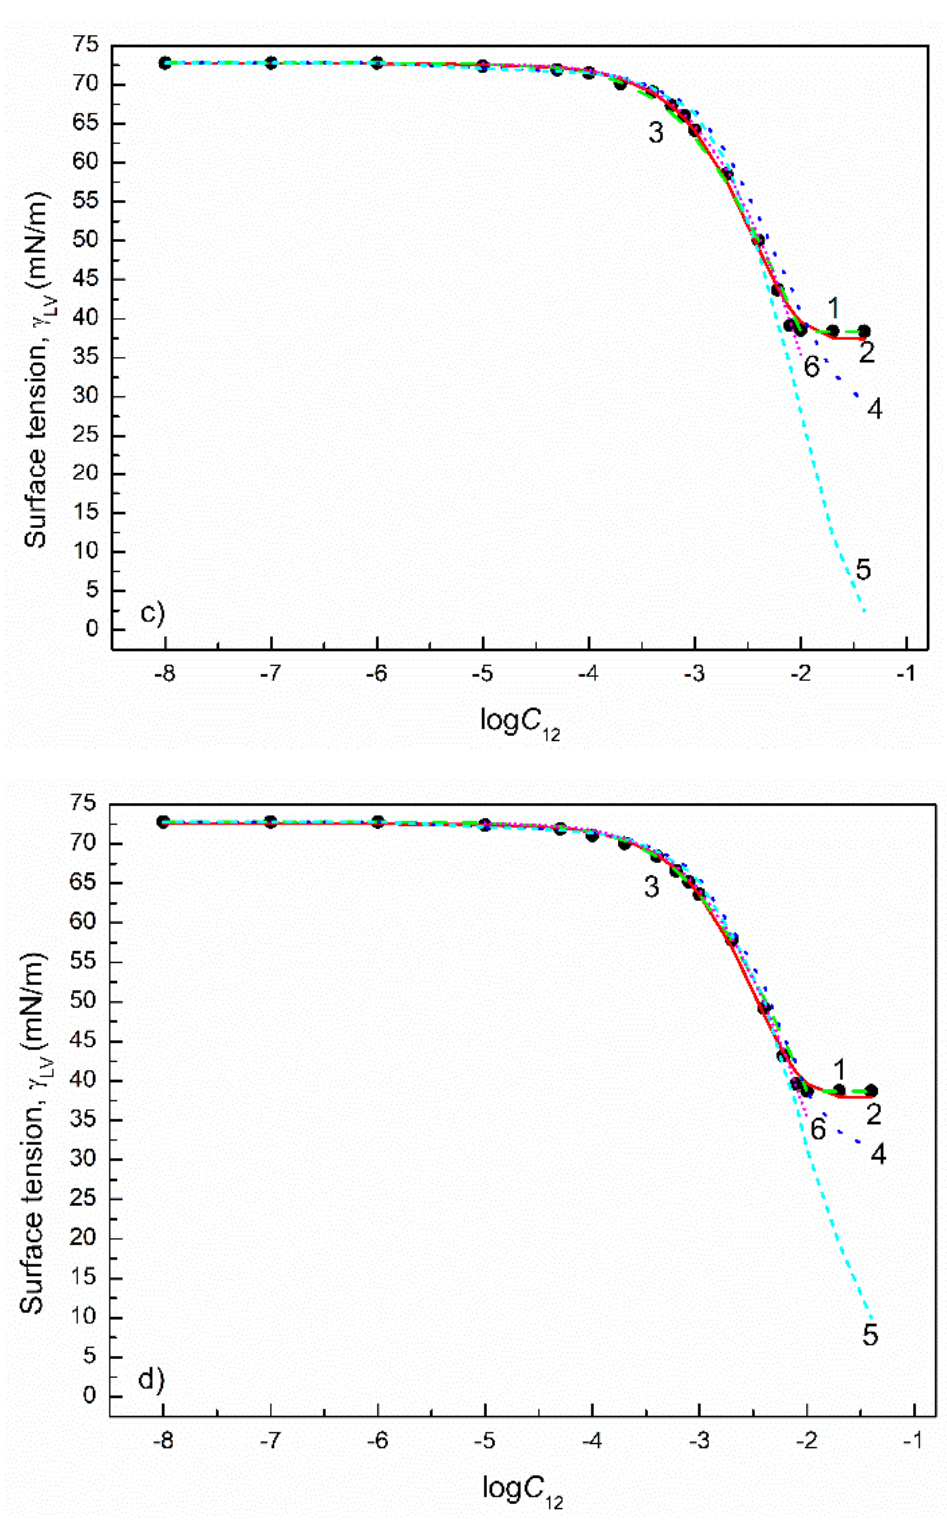
Figure 6. A plot of the surface tension ( γ LV ) of the aqueous solutions of SDDS+SDS mixtures at the SDDS mole fraction in the bulk phase ( α ) equal to 0.2 ( a ), 0.4 ( b ), 0.6 ( c ) and 0.8 ( d ) vs. the logarithm of the mixture concentration ( logC 12 ). Points 1 correspond to the measured values [28], curves 2–6 correspond to the values calculated from the exponential function of the second order (Equation (2)), Szyszkowski equation (Equation (3)), Fainerman and Miller equation (Equation (11)), independent adsorption (Equation (10)) and Joos equation (Equation (13)), respectively.